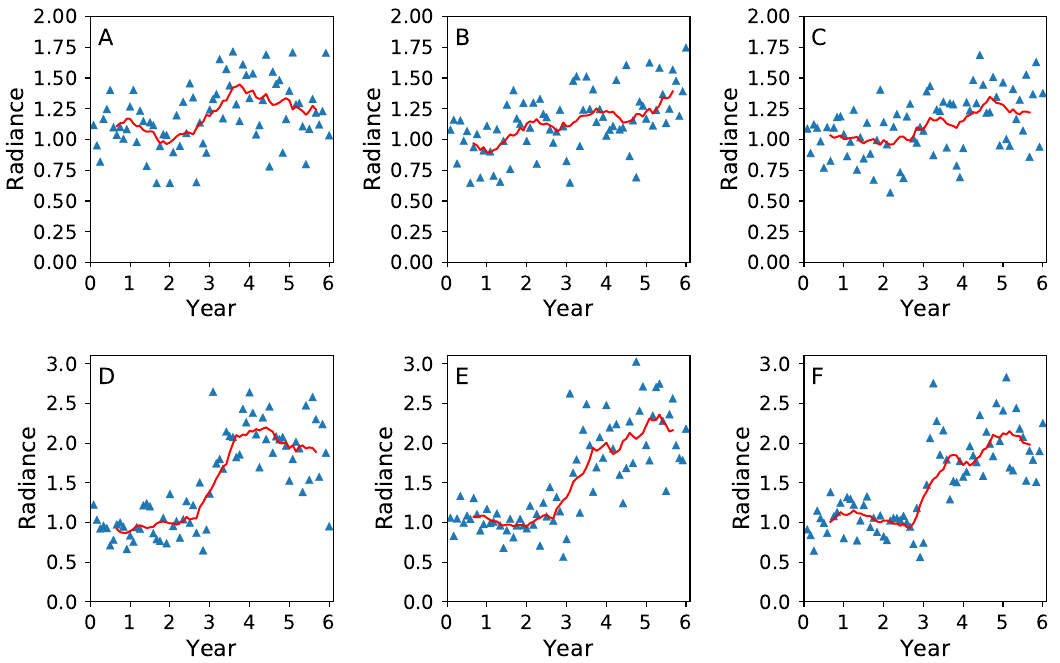
Figure 9. Simulated six-year DNB time series. In the top plots, the average radiance changes from 1 to 1.3 at the start of Year 3. In the bottom plots, the average radiance changes from 1 to 2 at the start of Year 3. A running centered 13 month mean is